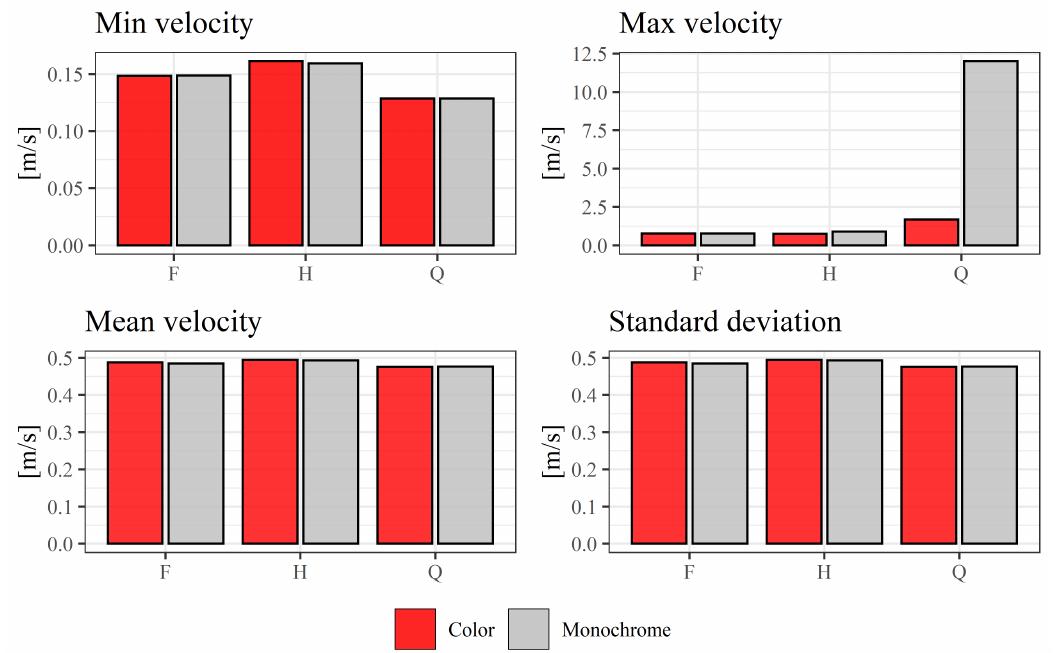
Figure 6. Outcome of the OTV algorithm for color and monochrome video streams at full (F), half (H), and quarter (Q)